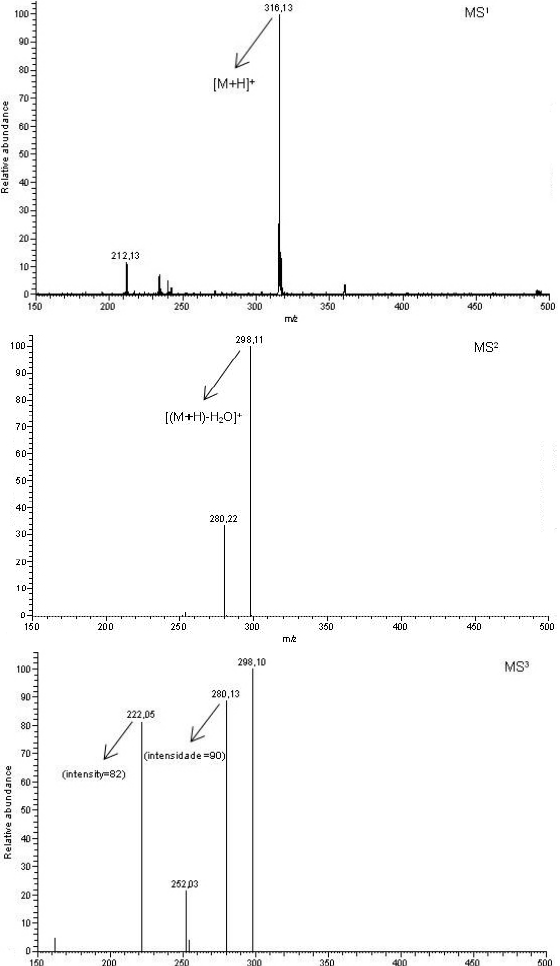
Figure 3. ESI mass spectra showing the parent and product ions and their corresponding m/z values of GA standard (25.0 mg L -1